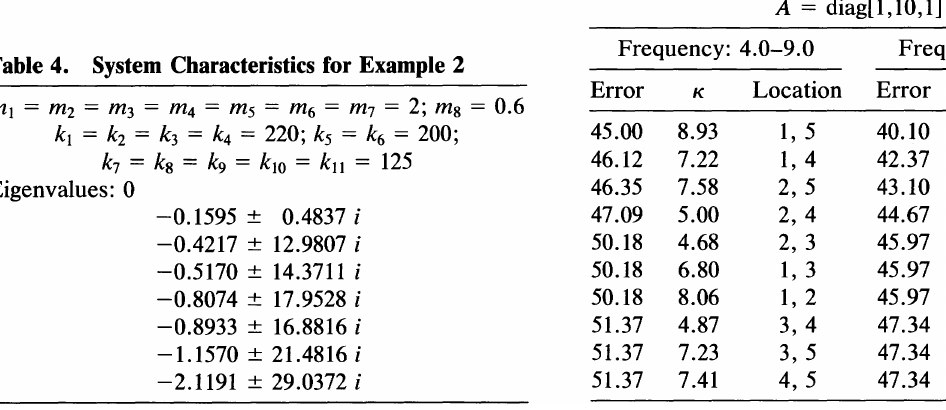
Table 4. System Characteristics for Example 2